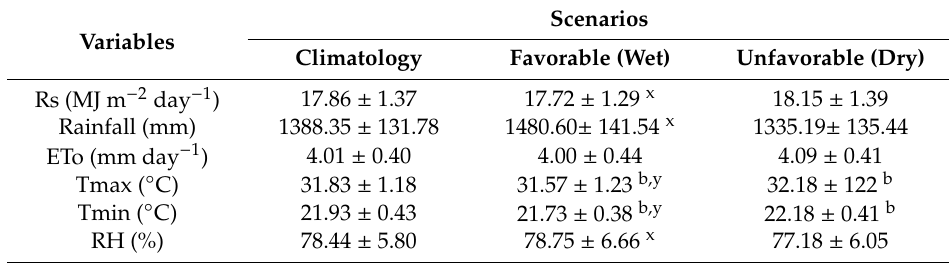
Table 4. Mean, standard deviation, and Dunn’s test result for the meteorological variables in the MATOPIBA region, considering the period from October to April of crop years from 1980 / 81 to 2012 / 13. Variables